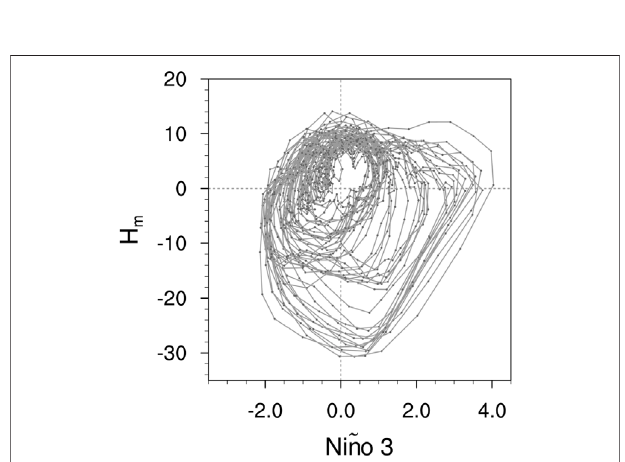
FIGURE 16 | Trajectories of ENSO events in the Niño 3 index (unit: ° C; horizontal axis) – zonal mean thermocline fl uctuation (unit: m; vertical axis) phase space. A total of ten percent of all the simulated ENSO events are randomly chosen for